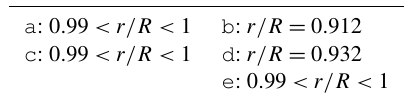
Table 2. The radial position where Eq. (19) is satisfied, for flow cases a to e .